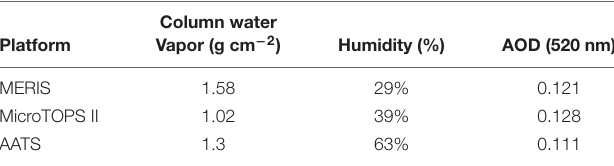
TABLE 2 | Summary of atmospheric parameters used for correction of the HIS imagery. Column water Platform